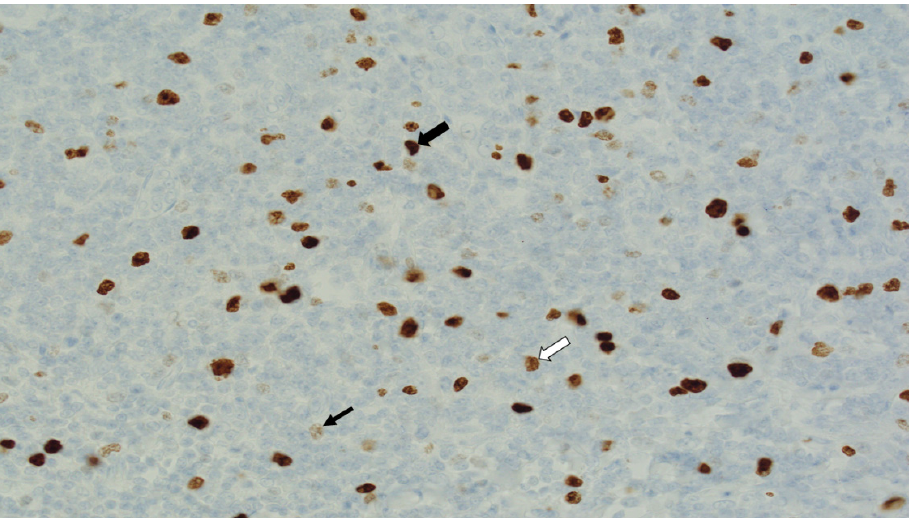
Figure 2. Figure demonstrating Ki-67 staining in lymphoid tissue illustrating the challenge required for digital image analysis in relation to assigning where the threshold for detection lies as evidenced by the differences in staining between cells from intense (black arrow) to intermediate (white arrow) to faint (thin arrow) (40 × Magnification). to faint (thin arrow) (40 ×